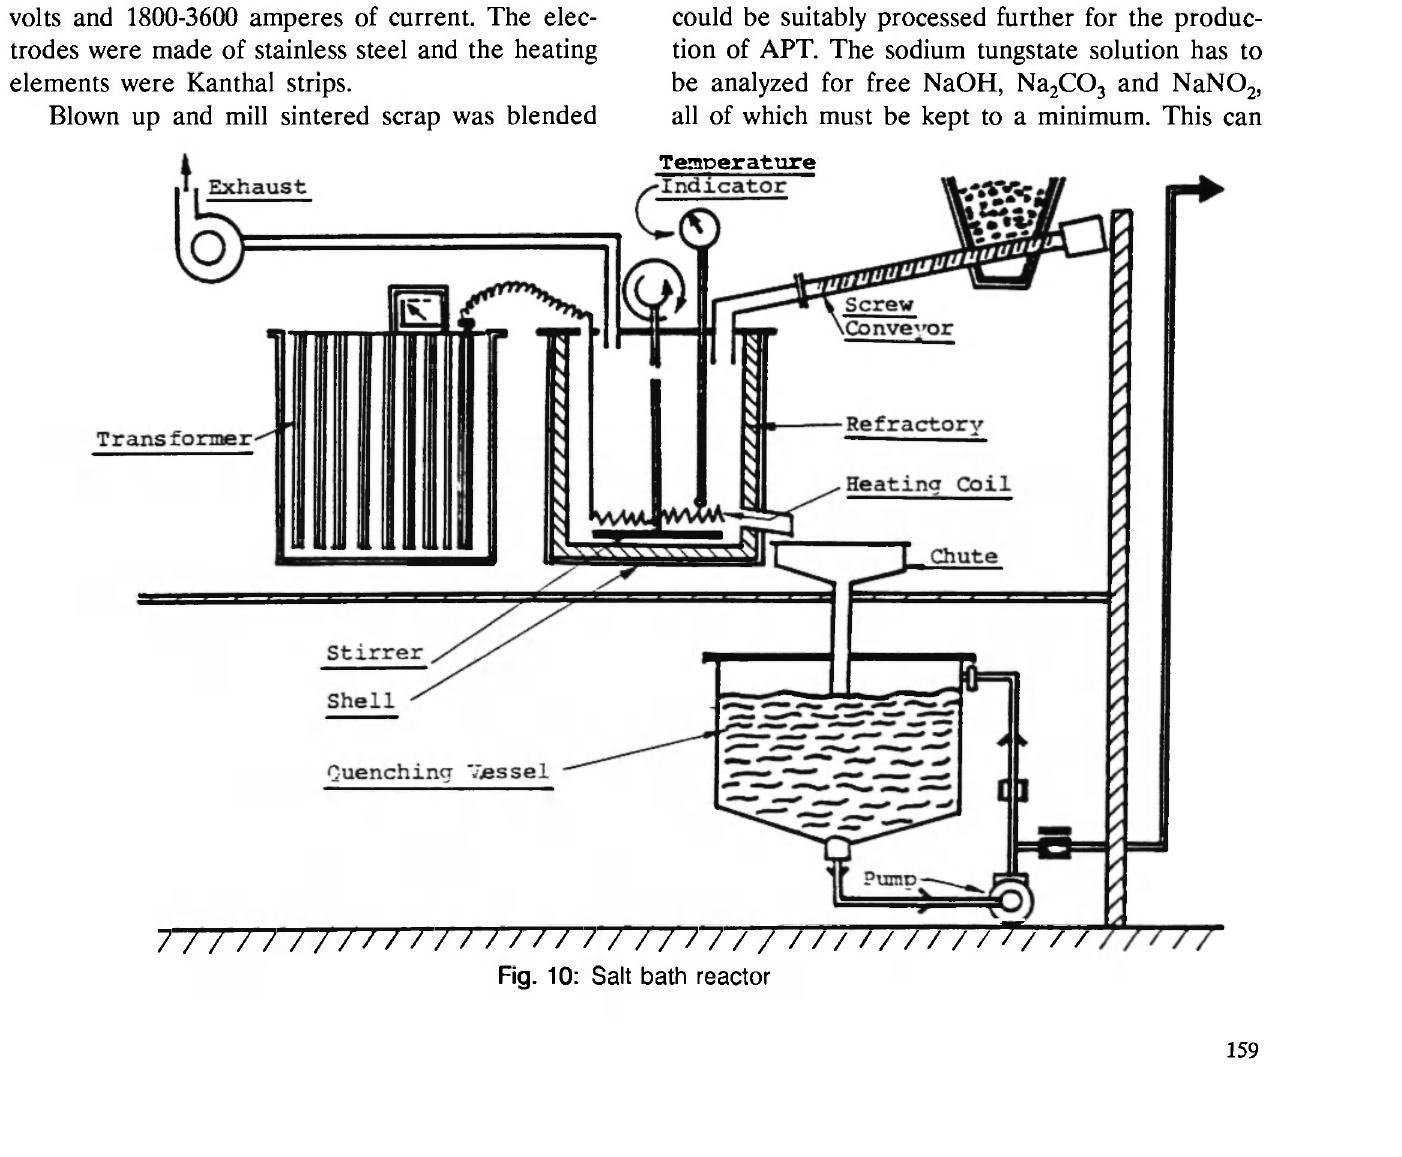
Fig. 10: Salt bath